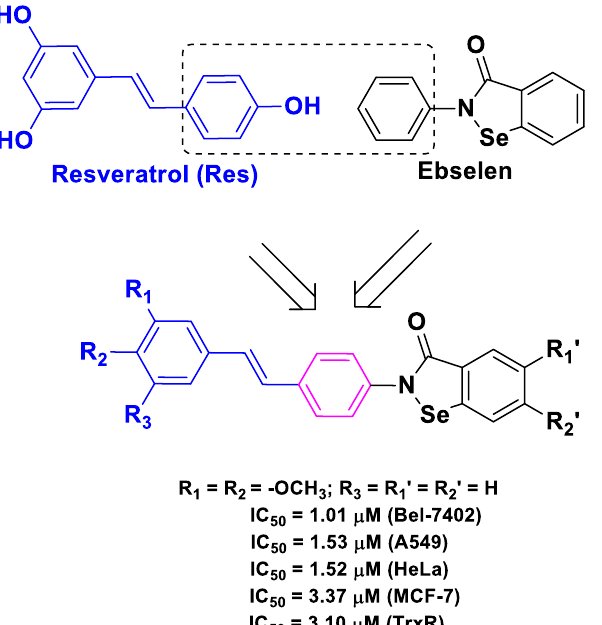
Figure 6. Structure and activity of the most potent chimeric compound developed by Yan et al. [48]. As the strategy to affect the Trx system turns out to be effective for a selective target- based anticancer drug design, another research group aimed to hybrid molecules aimed at this target. Ai et al. obtained chimeric hybrids by merging the pharmacophore of Cur with ligustrazine (tetramethylpyrazine; Figure 7) [57], the bioactive ingredient of a Chinese herb extract used for the treatment of cardiovascular and cerebrovascular diseases [71]. These hybrids significantly inhibited the proliferation of drug-sensitive (A549, SPC- A-1, LTEP-G-2) and drug-resistant (A549/DDP) lung cancer cells with negligible effects on non-tumor lung epithelial-like cells (Human Bronchial Epithelial cells, HBE) (Figure 7). Furthermore, they inhibited the Trx system, promoted intracellular ROS accumulation (as expected because of the presence of the ROS promoting agent ligustrazine), and induced apoptosis (assessed for the most potent derivative). Additional in vitro studies showed also that these hybrids inhibit different tumor-related pathways, and in vivo studies (A549/DDP xenografts) confirmed the antitumor efficacy [57].